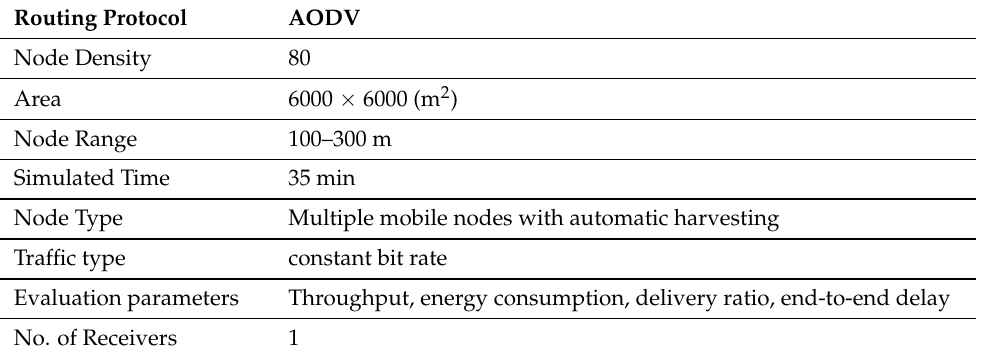
Table 1. Simulation